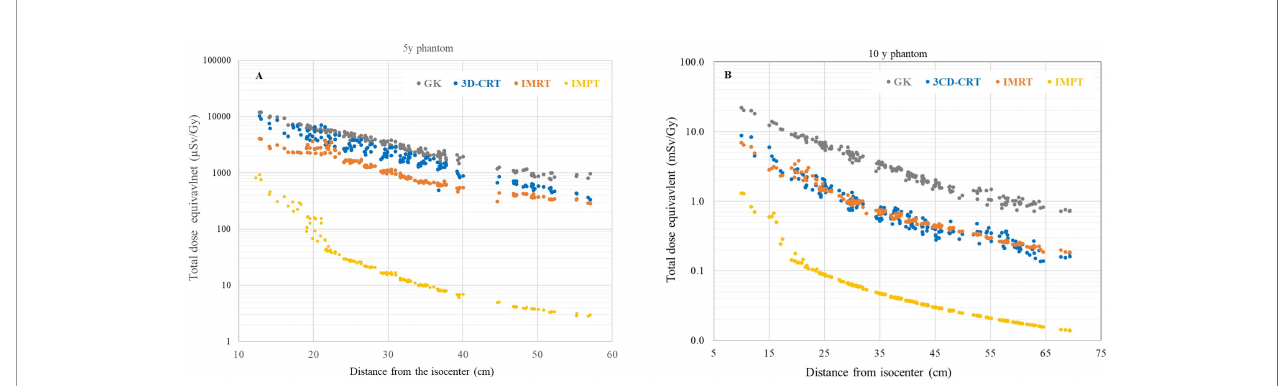
FIGURE 8 | (A, B) Comparison of total dose equivalent organ doses for all irradiation techniques as function of distance from the isocenter for 5- (A) and 10-year- old (B) phantoms.